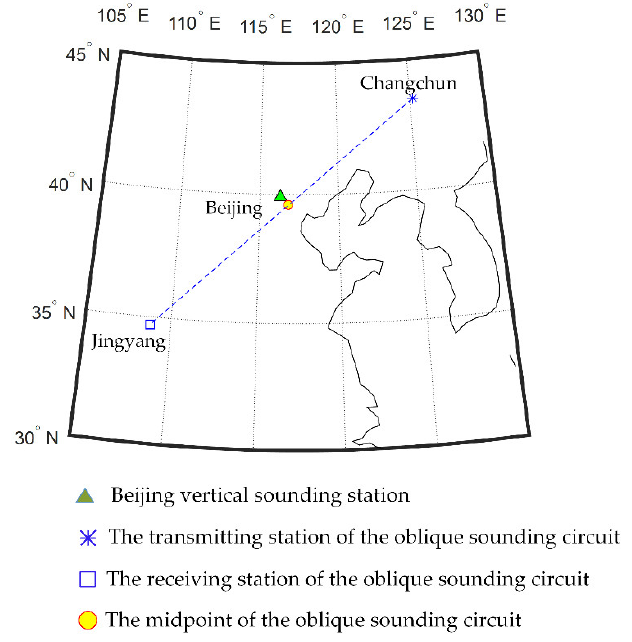
Figure 2. Map of oblique and vertical sounding stations.